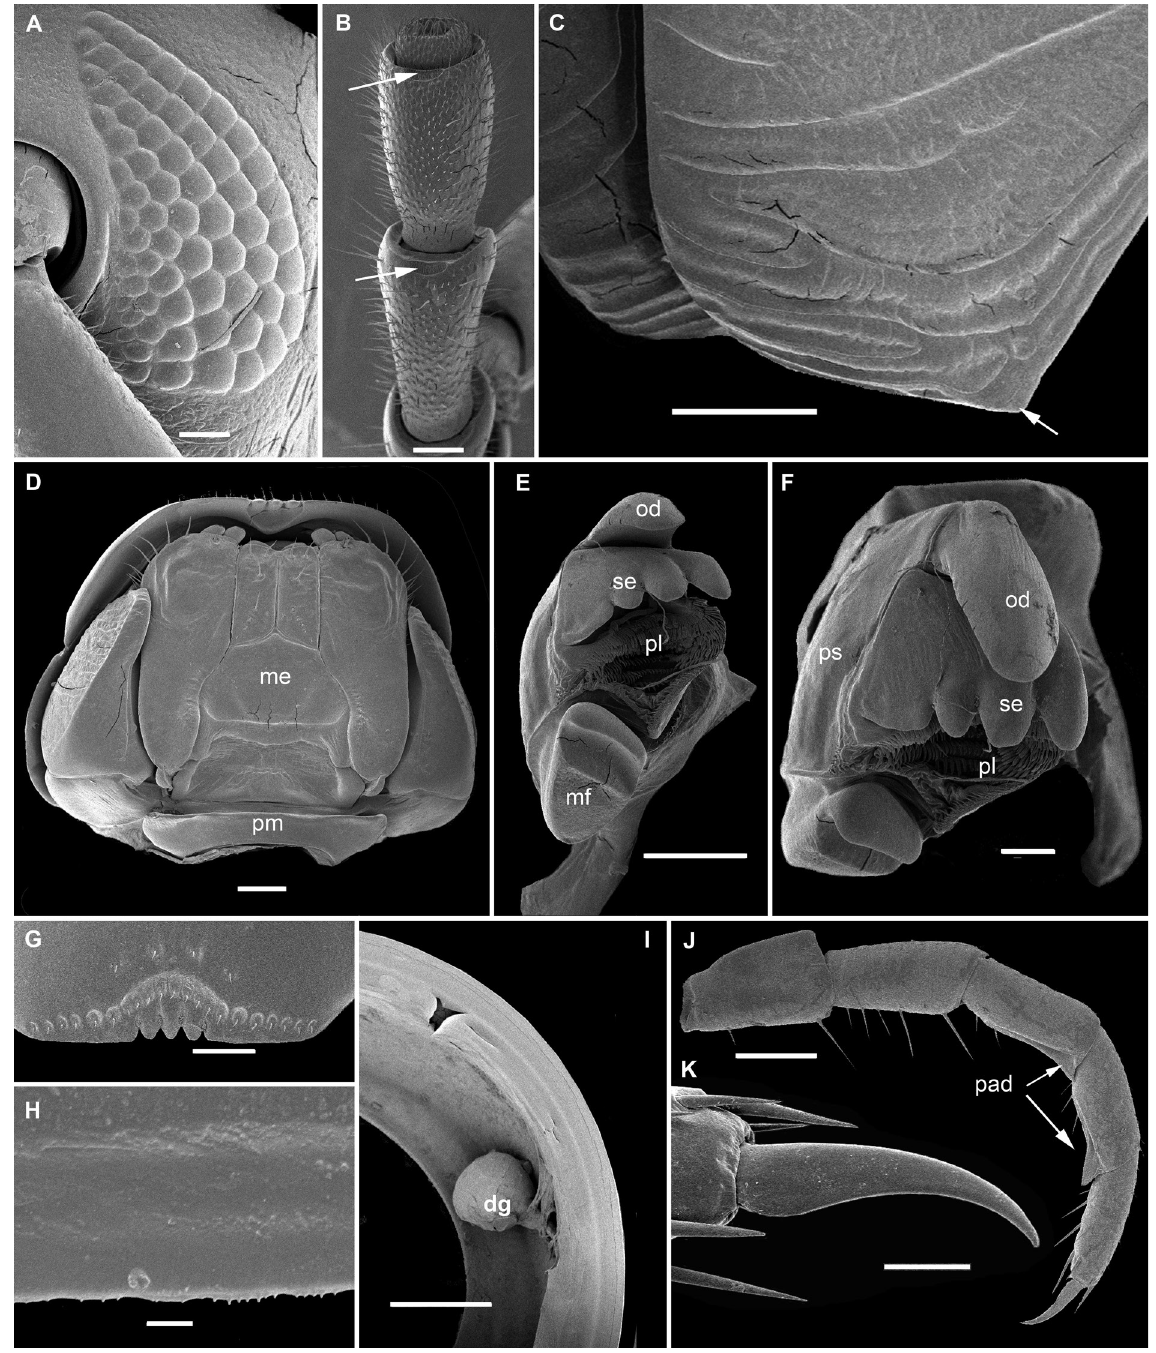
Fig. 4. Sechelleptus arborivagus sp. nov., paratype, ♂ (BE_RMCA_MYR.Dip.22875). SEM views. A . Ommatia, frontal view. B . Antennae, ventral view, arrows pointing to sensilla basiconica. C . Lateral view of collum, arrows pointing to the anteroventral angle 80–90°. D . Head, ventral view. E . Mandible, ventral view. F . Mandible, frontal view (F). G . Clypeus, frontal view. H . Limbus. I . Defensive gland. J . Walking leg, lateral view. K . Tarsal claw, lateral view. Abbreviations: dg = defensive gland; me = mentum; od = odontomere; pl = pectinate lamellae; pm = prementum; pad = tibial pad; ps = psectomere; se = sectile edge. Scale bars: A–B, F = 200 µm; C–E, G, J = 500 µm; H = 5 µm; I = 1 mm; K = 100